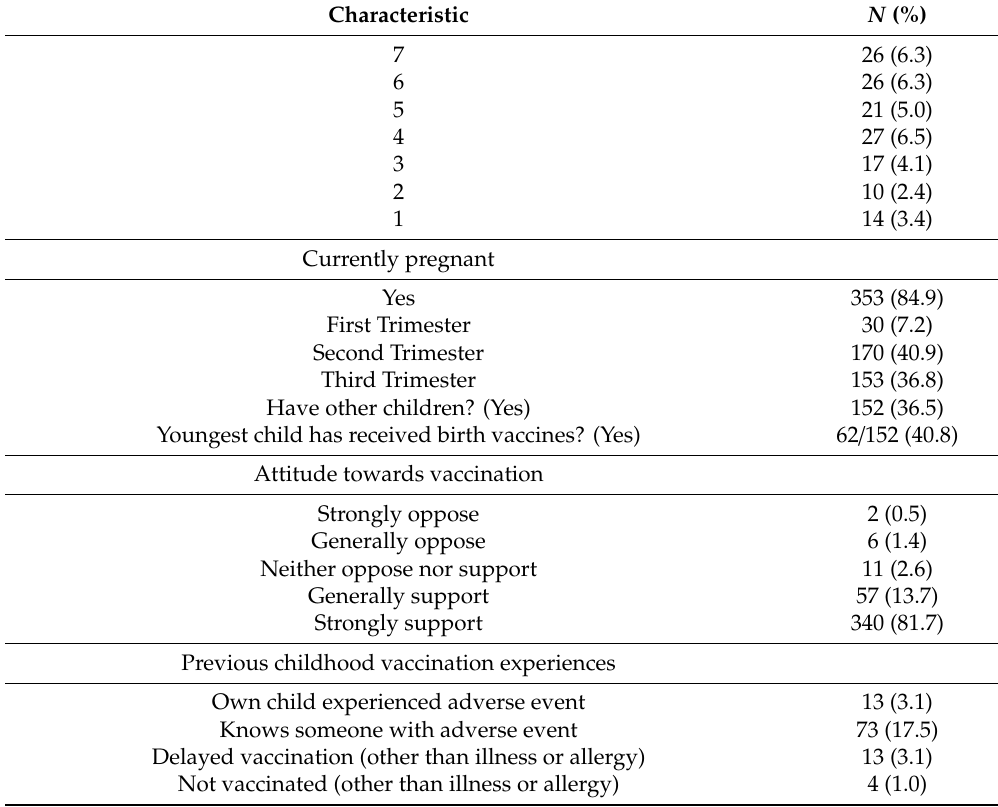
Table 3. Comparison of Hesitancy and Informed Decision Making Pre and Post Intervention. Survey Item